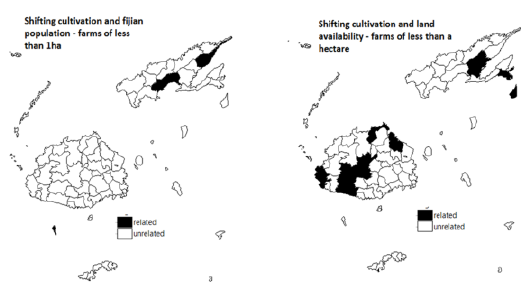
Figure 17. Critical maps for farms under 1ha showing areas with high or very high values of Fijian population and of land use intensity (a); and high or very high values of land availability and land use intensity (b).